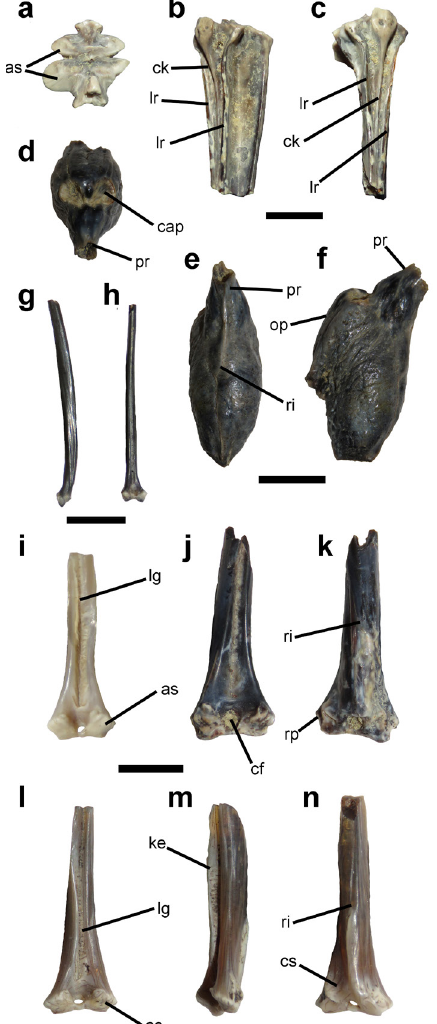
Figure 6. Percichthyidae genus and species indeterminate. Spines and pterygiophores. a-c, first anal pterygiophore (LIEB-PV 8004) in a, distal; b, right lateral; c, posterior views. d-f, first dorsal hyperostosed pterygiophore (LIEB-PV 8005) in d, proximal; e, posterior; and f, lateral views. g-h, fin spine (LIEB-PV 8004) in g, lateral; and h, posterior views. i, articular end of fin spine (LIEB-PV 8004) in posterior view. j-k, articular end of fin spine (LIEB- PV 8004) in j, posterior, and k, anterior views. l-m, articular end of fin spine (LIEB-PV 8004) in l, posterior; m, lateral; and n, anterior views. References: as, articular surface; cap, cup-shaped articular surface for spine; cf, central foramen; cs, concavity for preceeding spine; ck, central keel; ke, longitudinal keel; lg, longitudinal groove; lr, lateral ridge; op, osseous platform; pr, proximal radial; ri, ridge; rp, rounded process. Scale bar: a-c, g-n, 0.5 cm; d-f, 1